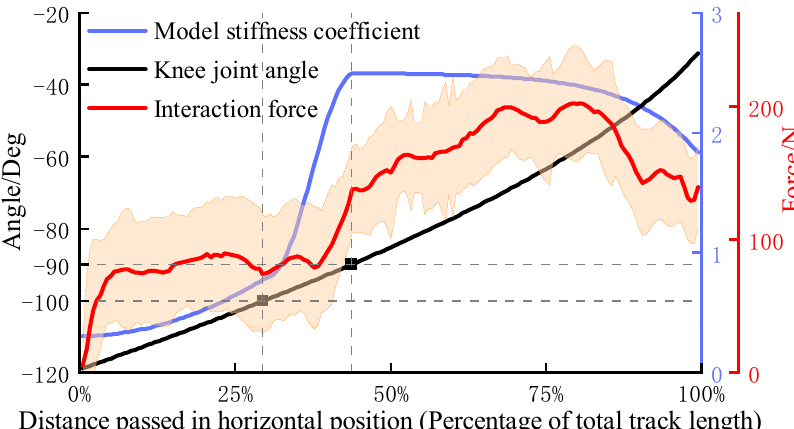
Figure 7. Performance testing of admittance control.